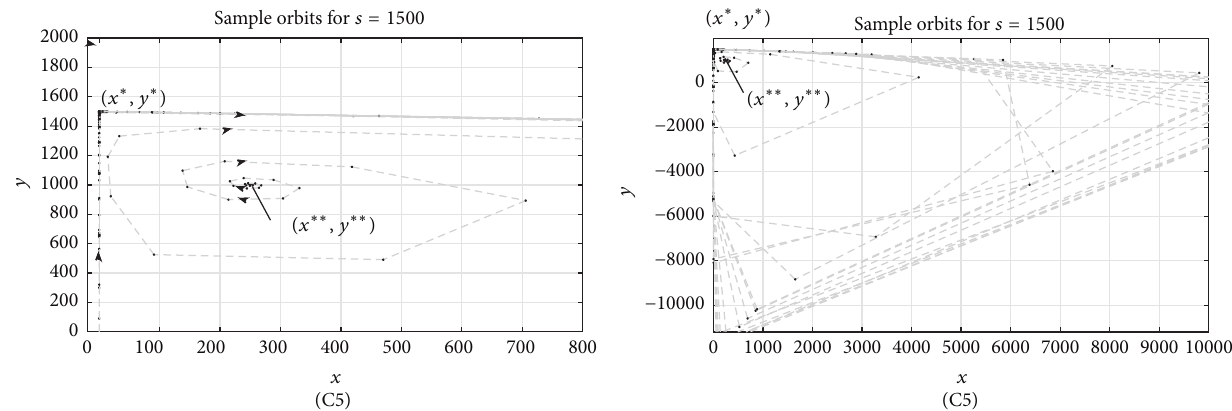
Figure 4: Examples illustrating condition (C5) from Table 1. The right figure is a “big picture” of the same